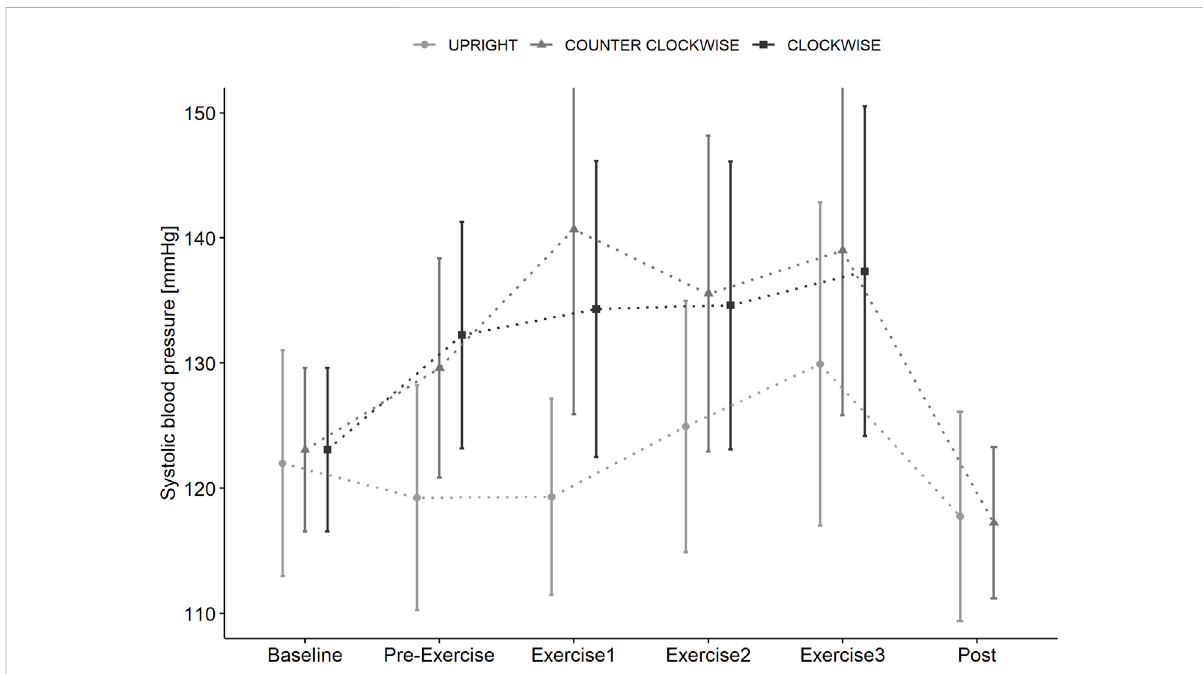
FIGURE 5 Systolic blood pressure measured in supine position (BASELINE) prior to standing (PRE-EXERCISE) in the UPRIGHT condition, and when passively rotated (PRE-EXERCISE) clockwise (CLOCKWISE) and counter-clockwise (COUNTER-CLOCKWISE) with 1 g at the participants center of massinadditiontodirectlyfollowingContra-lateral,WoodChopper andCrunchexercise(BREAK1,BREAK2,BREAK3)anduponcompletion(POST) of each condition. Data as mean